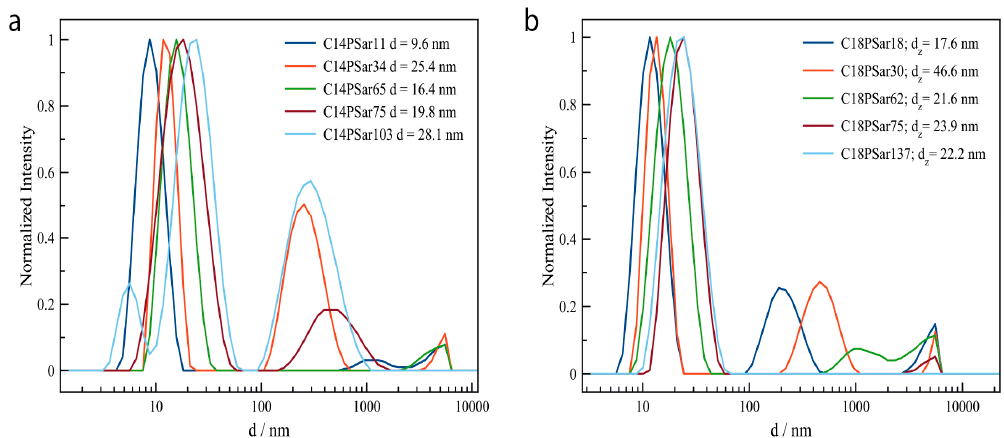
Figure 3. Intensity-weighted diameter distribution of lipopolypeptoids in aqueous solution determined by dynamic light scattering (DLS). ( a ) Series of tetradecyl amine (C 14 )-based lipopolypeptoids; and ( b ) series of stearyl amine (C 18 )-based lipopolypeptoids.